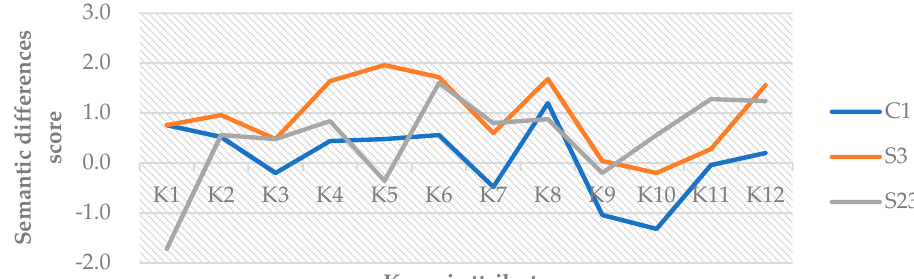
Figure 4. Comparison between the V A of S3 and S23 and the V T of C1. Table 5. Final evaluation scores for target feeling and acquired feeling.